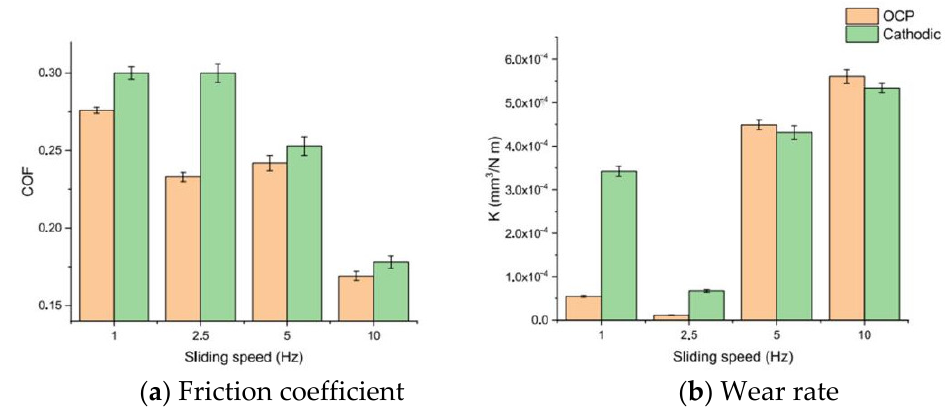
Figure 6. The coefficient of friction (COF) ( a ) and the specific wear rate K ( b ) as a function of the sliding speed under cathodic potential and OCP [27].